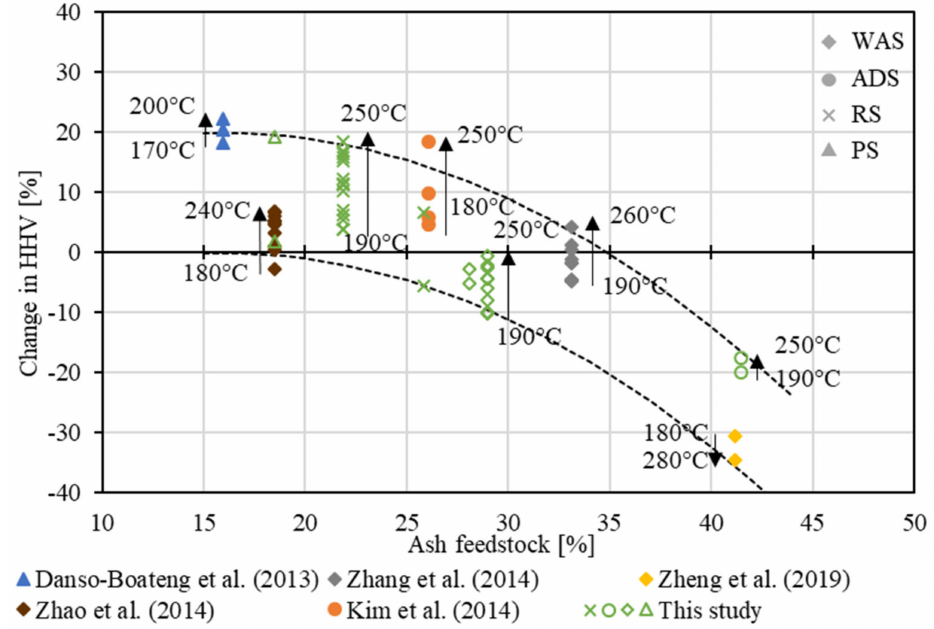
Figure 5. Correlation of the ash content of the feedstock and the change of HHV calculated by (HHV hydrochar -HHV feedstock )/HHV hydrochar · 100. Data adapted from: Danso-Boateng et al. [46]: PS, 190 ◦ C, 200 ◦ C, 4 h; Zhang et al. [4]: 190 ◦ C, 260 ◦ C, 1 h; Zhao et al. [2]: WAS, 180 ◦ C, 200 ◦ C, 220 ◦ C, 240 ◦ C, 0.25 h, 0.5 h, 0.45 h; Zheng et al. [44]: WAS, 180 ◦ C, 230 ◦ C, 280 ◦ C, 1 h; Kim et al. [45]: ADS 180 ◦ C, 200 ◦ C, 220 ◦ C, 250 ◦ C, 0.5 h; this study: see Table 1, 190 ◦ C, 220 ◦ C, 250 ◦ C at various reaction times.